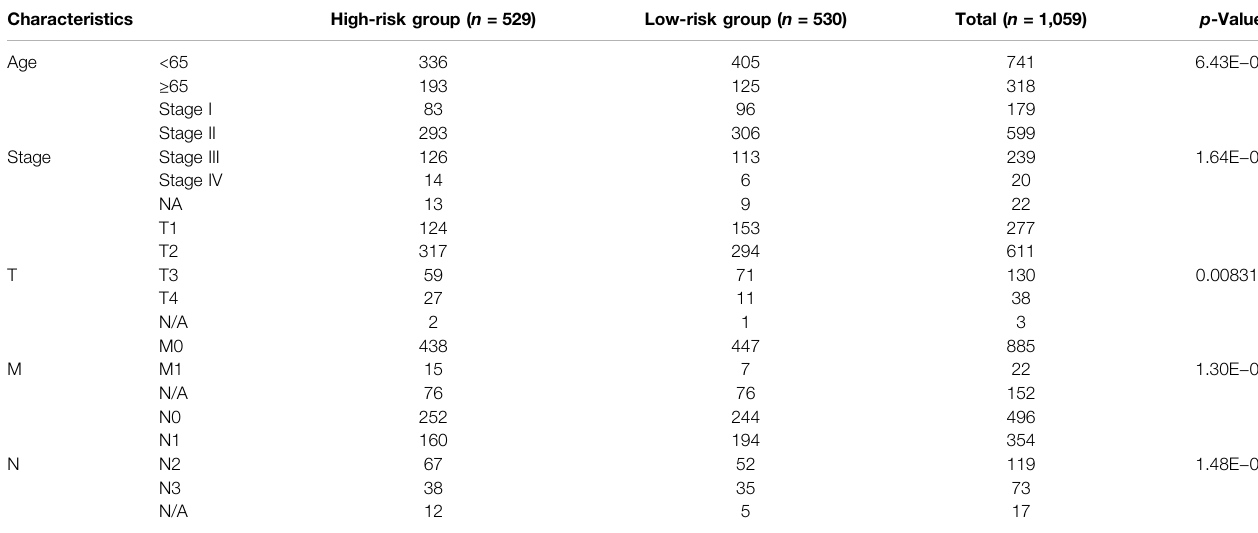
TABLE 2 | Clinicopathological characteristics of high- and low-risk subgroups in the discovery set.